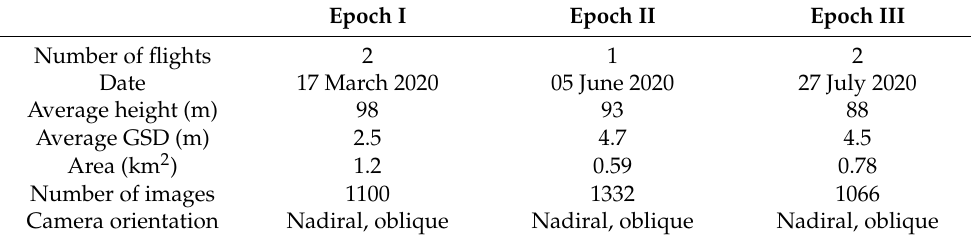
Table 3. Characteristics of the three flights. GSD = ground sample distance. Epoch I Epoch II Epoch III Number of